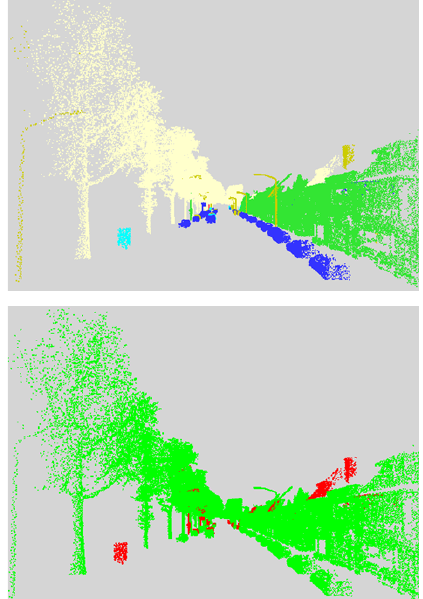
Figure 15 Street view from part of the classified data (top) and corresponding correctness (bottom).